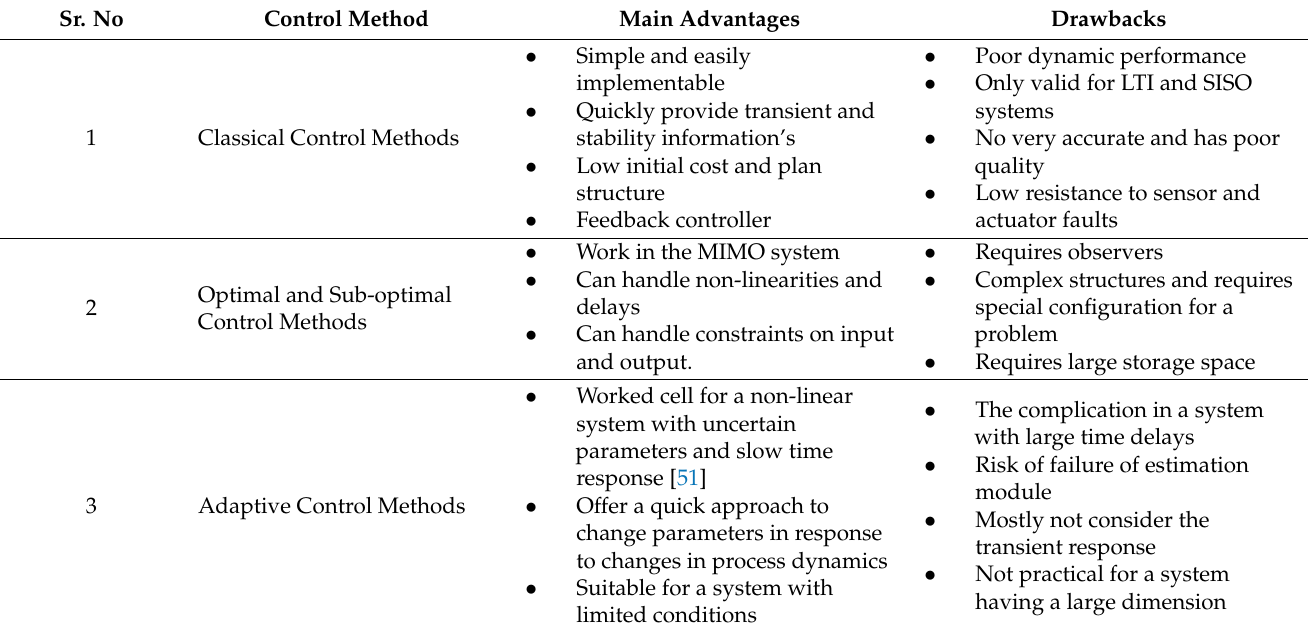
Table 2. Summary of control techniques with main advantages and disadvantages. Sr.